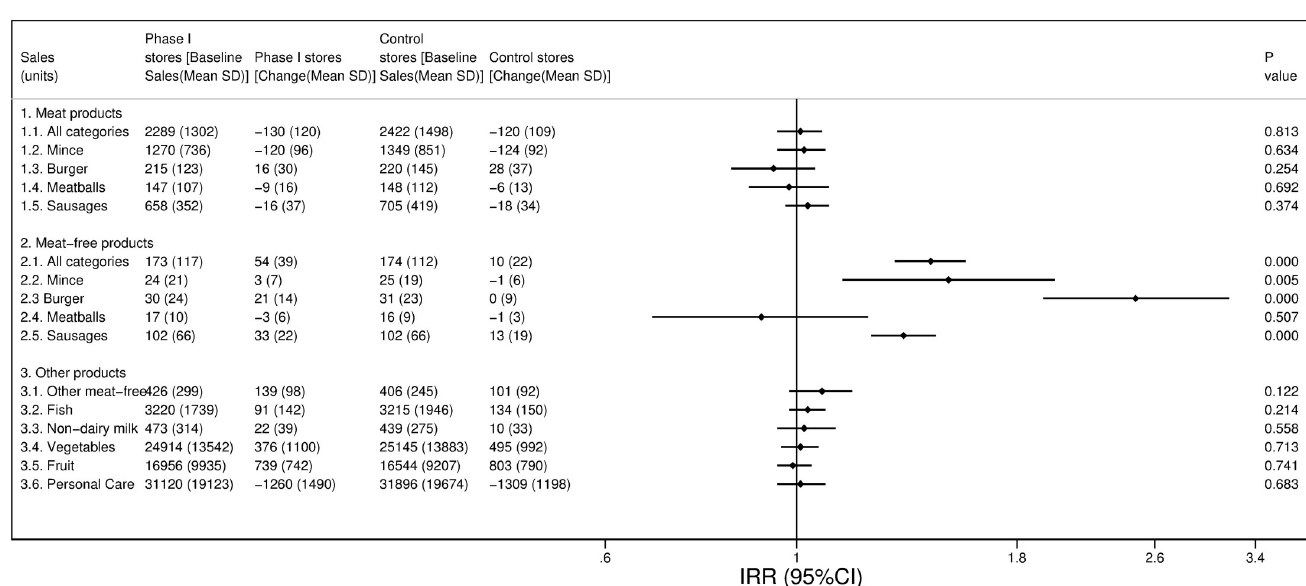
Fig 1. Average baseline sales (units/items sold) per store per week and comparison of changes between intervention and control stores over the Phase I intervention period. � IRRs (95% CI) comparing changes in intervention stores vs. control stores using hierarchical negative binomial models with fixed effect adjustment for store affluence, store age group, store ethnicity, store area and average units sold per week in 12-week pre-intervention period (week commencing September 2, 2018 to week commencing November 18, 2018), and a random effects term for matching group. IRR, incidence rate ratio.